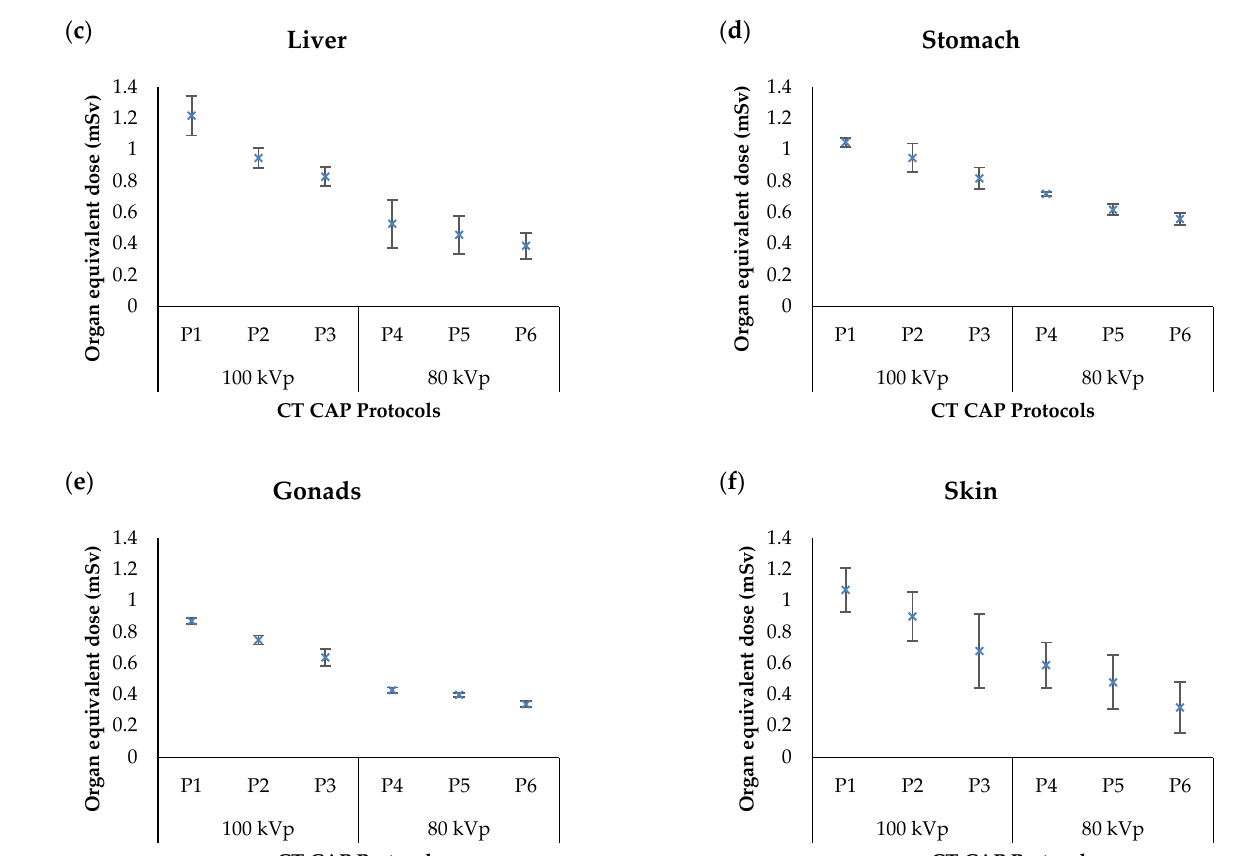
Figure 3. The mean organ-absorbed doses of standard pediatric CT CAP examinations with varying tube potential and tube current in: ( a ) Thyroid, ( b ) lungs, ( c ) liver, ( d ) stomach, ( e ) gonads, and ( f ) skin. Table 3. Organ Equivalent Dose from TLD measurement from optimization protocols.